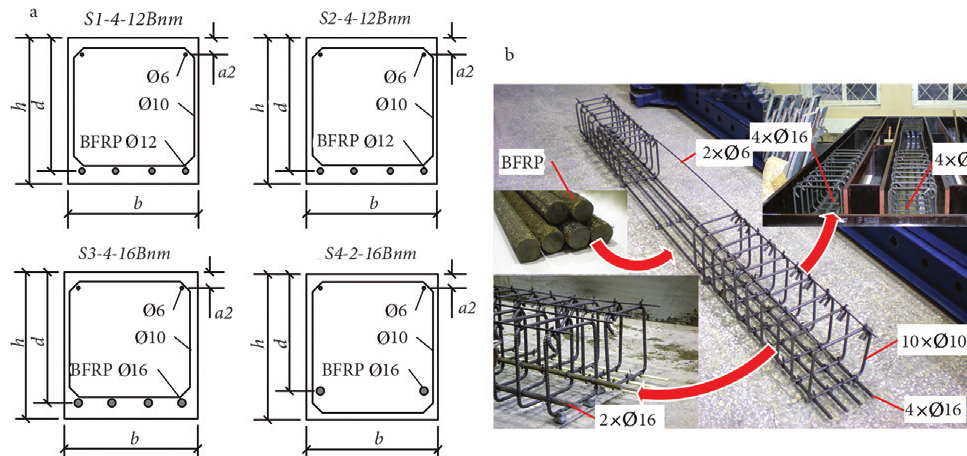
Fig. 1. Reinforcement schemes of the beams: a – cross-sections of the beams; b – preparation for casting Table 1. Main characteristics of the experimental beams